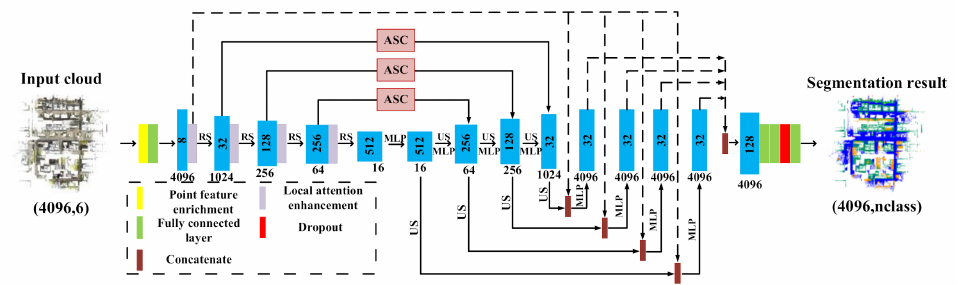
Figure 1. The framework of the proposed Multi-Scale Attentive Aggregation Network (MSAAN). The numbers in and below the blue block are the channel number of features and the point number of inputs, respectively. RS, US, MLP, and “nclass” are for random sampling, up-sampling, multi-layer perceptron, and the number of classes,